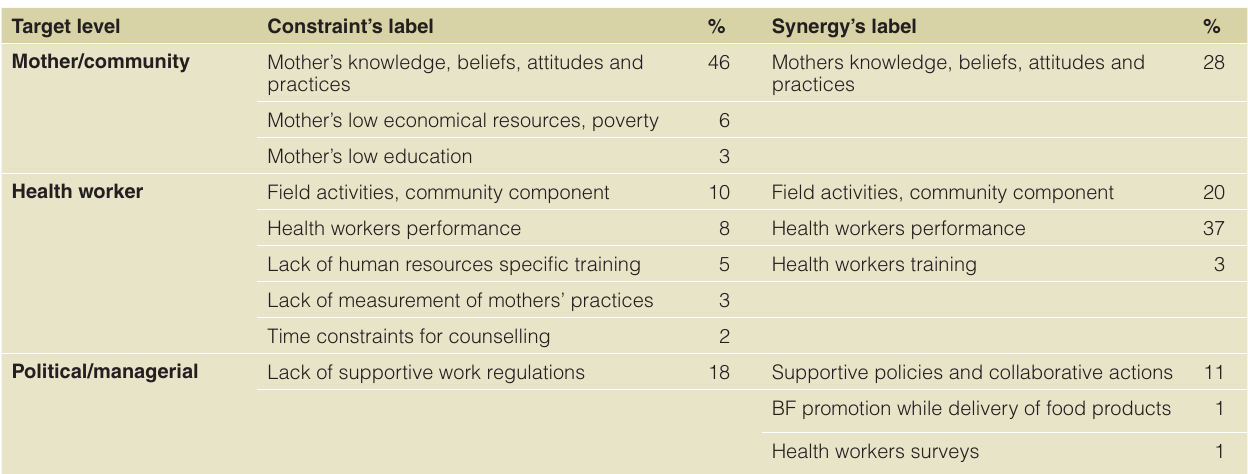
Table 2. Classification of identified exclusive breastfeeding constraints and synergies according to their target level and label together with the percentage of respondents that agreed with each label. Target